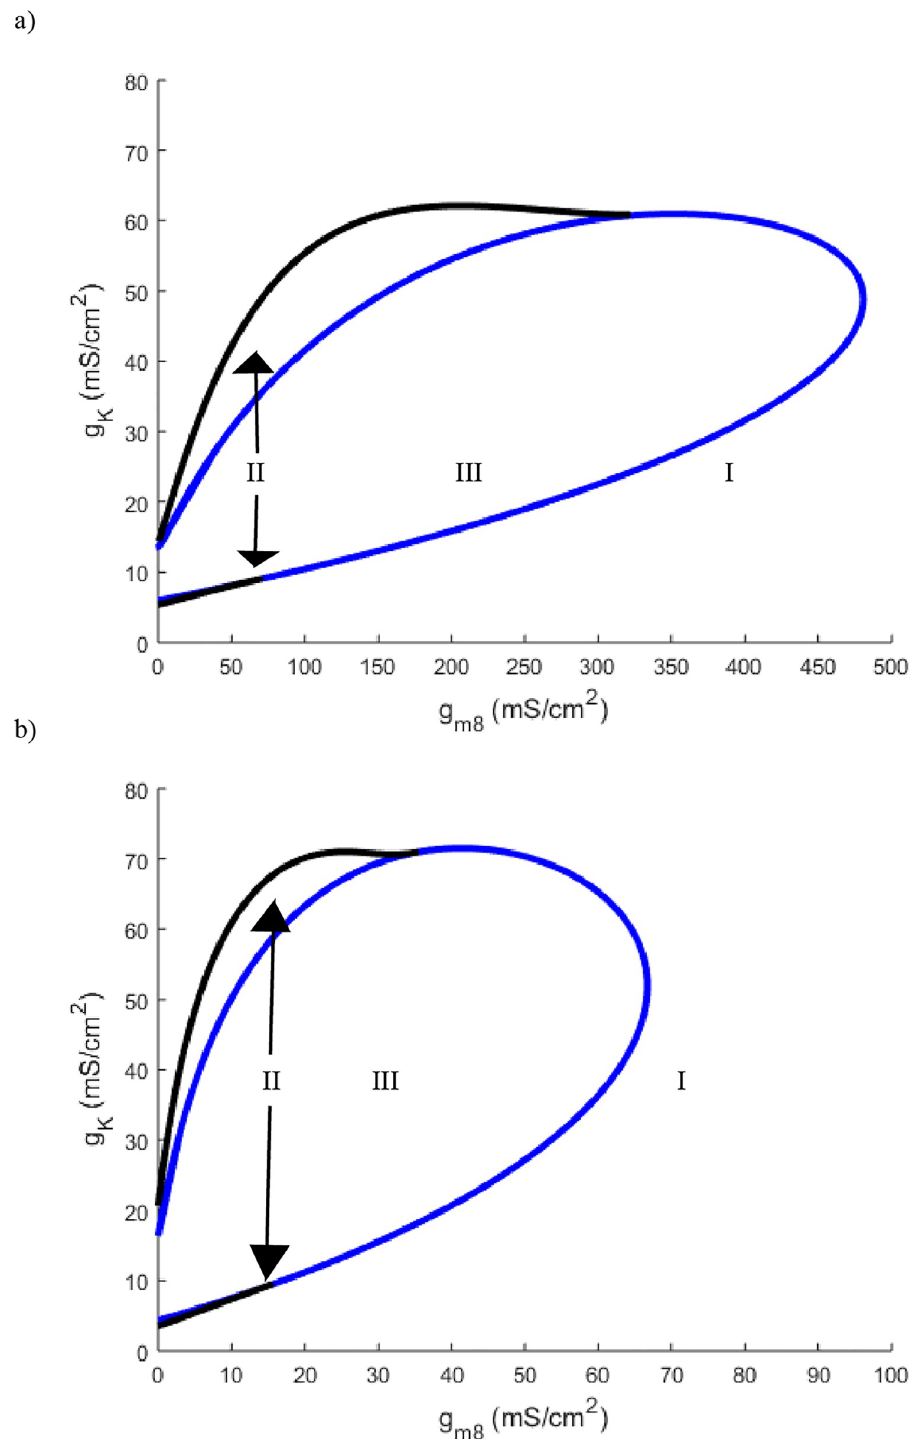
Fig 11. a) Two parameter bifurcation of g m 8 plotted against g K with temperature set to 25˚C. b) Two parameter bifurcation of g m 8 plotted against g K with temperature set to 15˚C. Curve color and labeled regions are identical in meaning to those in Fig 1.